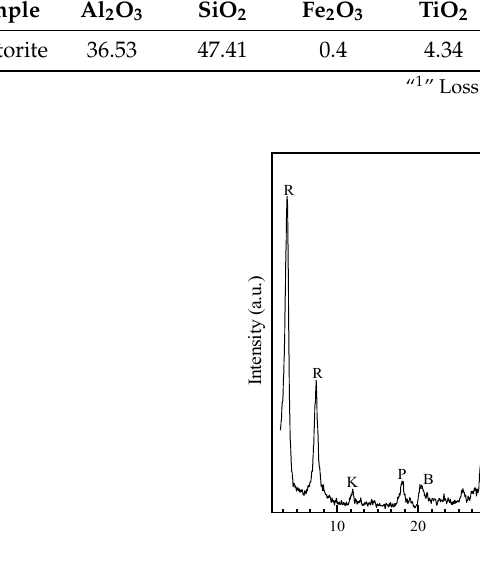
Table 1. Chemical composition of mineral sample (mass fraction, %).